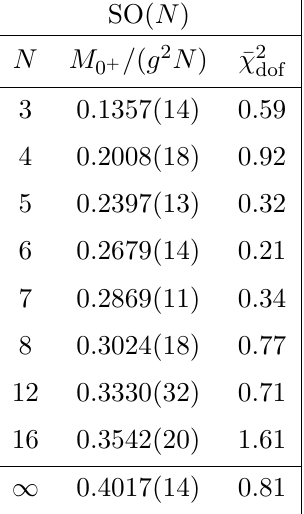
Table 30 . Lightest SO( N ) glueball, M , in units of the ’t Hooft coupling, g 2 N , and the (cid:31) 2 per 0 + degree of freedom of each continuum extrapolation. Also shown is the large- N